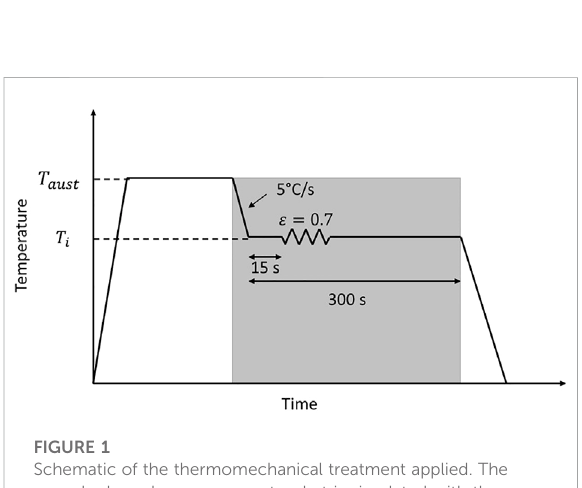
FIGURE 1 Schematic of the thermomechanical treatment applied. The grey shadowed area represents what is simulated with the modeling tool. T aust (cid:1) 1 , 250 ° C and T i (cid:1) 900 , 1 , 000 , and1 , 100 ° C